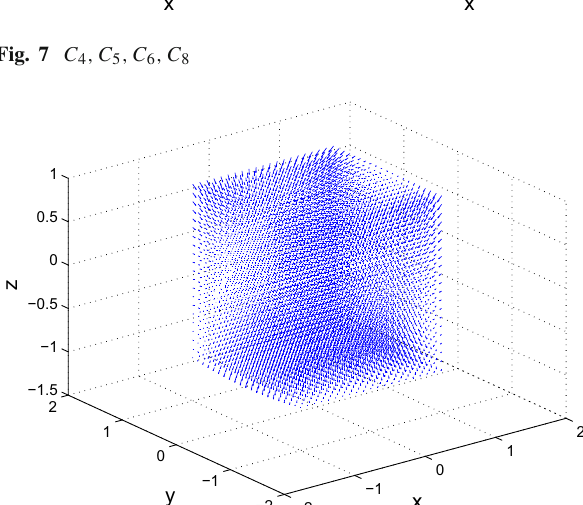
Fig. 7 C 4 , C 5 , C 6 , C 8